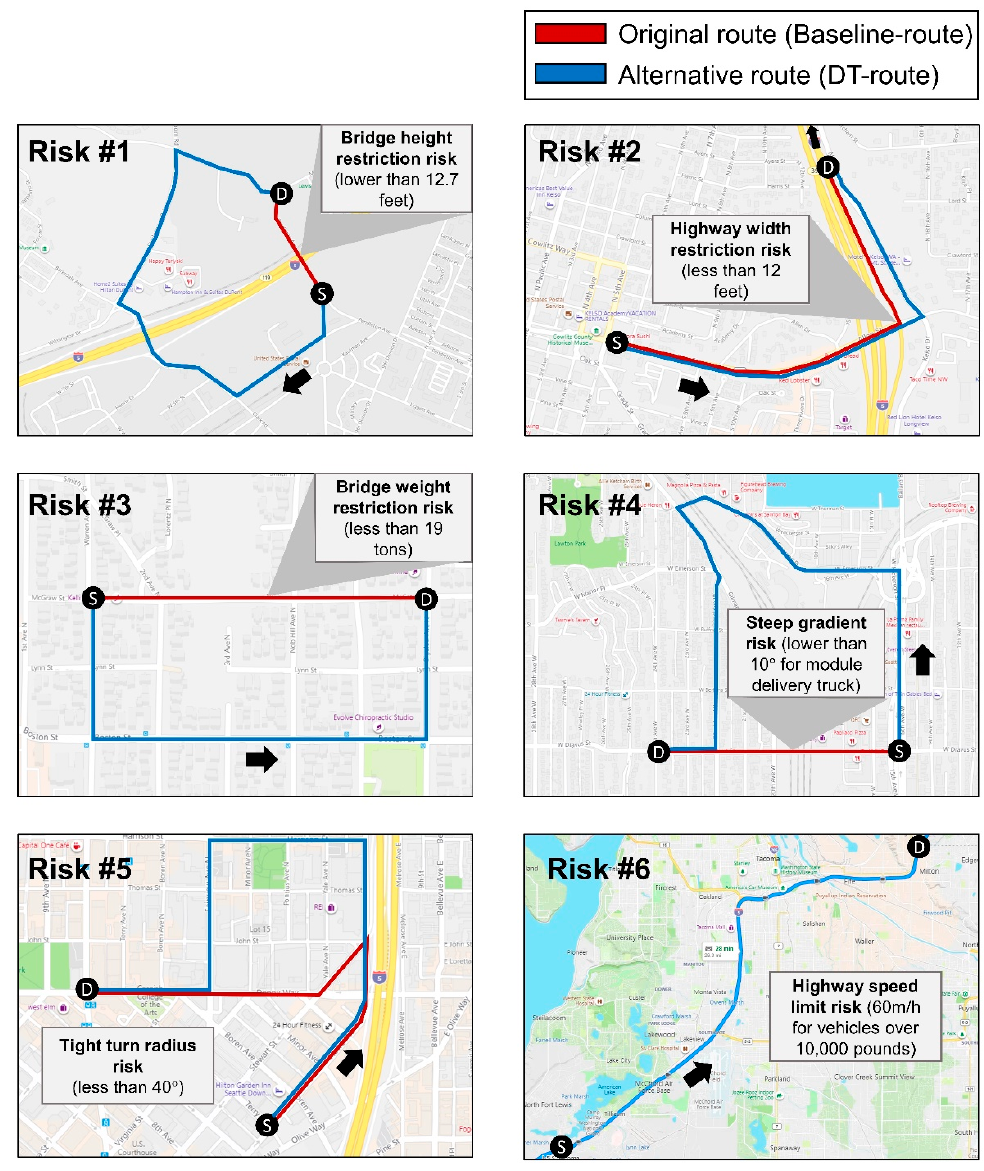
Figure 3. Six risk types identified from the logistics risk assessment.